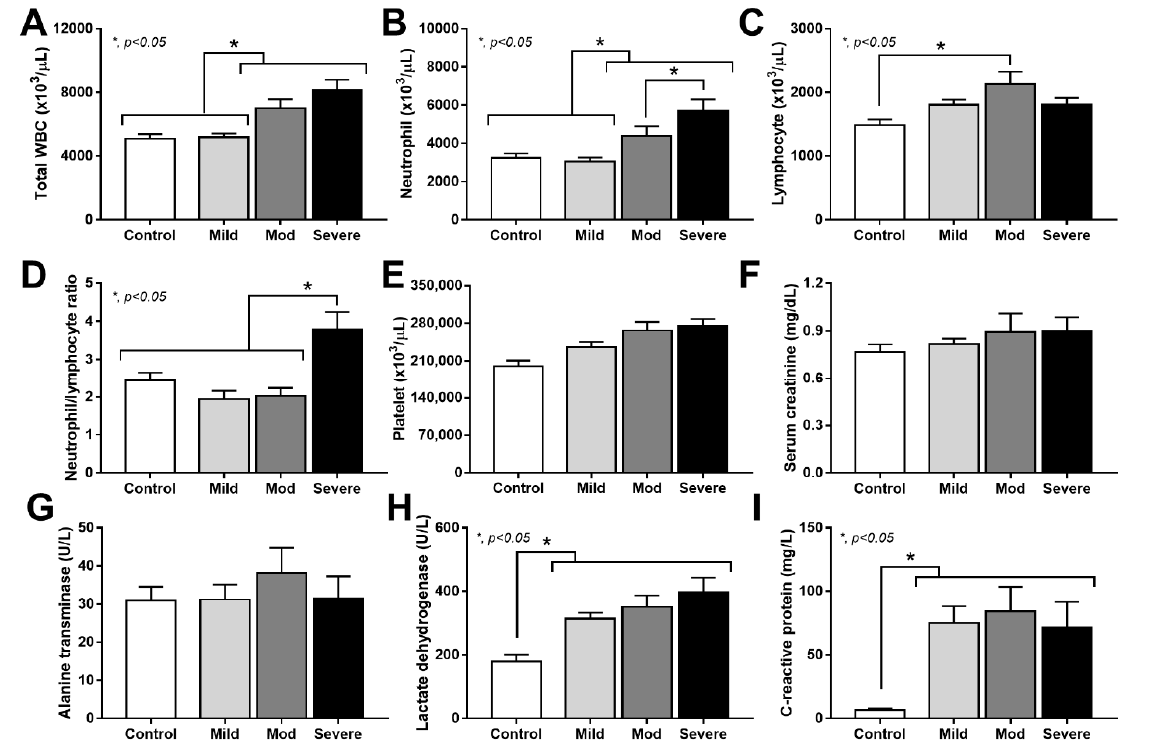
Figure 1. Characteristics of patients with COVID-19 in different severities—mild ( n = 27), moderate ( n = 28), and severe ( n = 20), versus healthy control ( n = 15), as indicated by total peripheral white blood cell count (WBC) ( A ), blood neutrophils and lymphocytes ( B , C ), neutrophil/lymphocyte ratio ( D ), platelet count ( E ), serum creatinine ( F ), alanine transaminase (ALT) ( G ), lactate dehydrogenase (LDH) ( H ), and C-reactive protein (CRP) ( I )—are demonstrated. *— p < 0.05 between the indicated groups as determined by ANOVA with Tukey’s analysis.